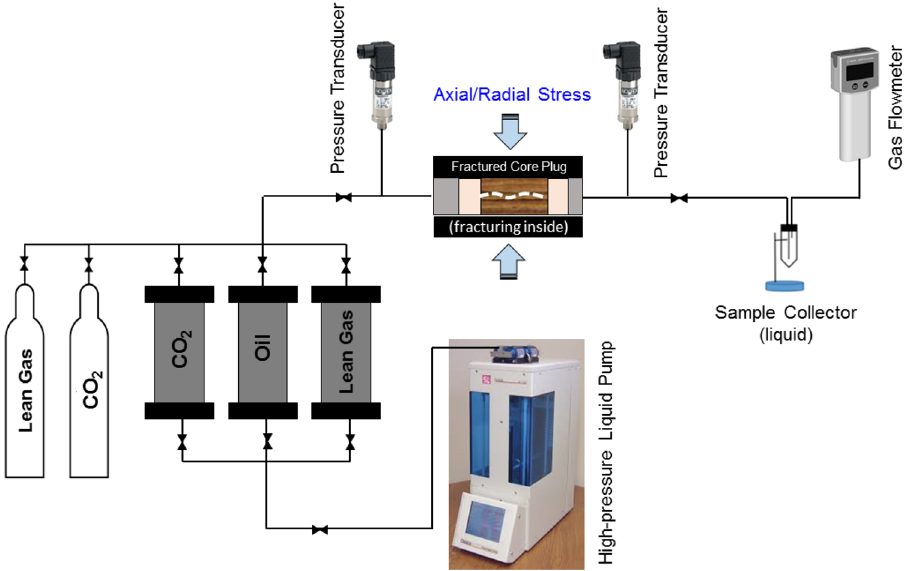
Figure 2. Schematic of the experimental setup designed and built in-house for the cyclic solvent (gas) injection (HNP)